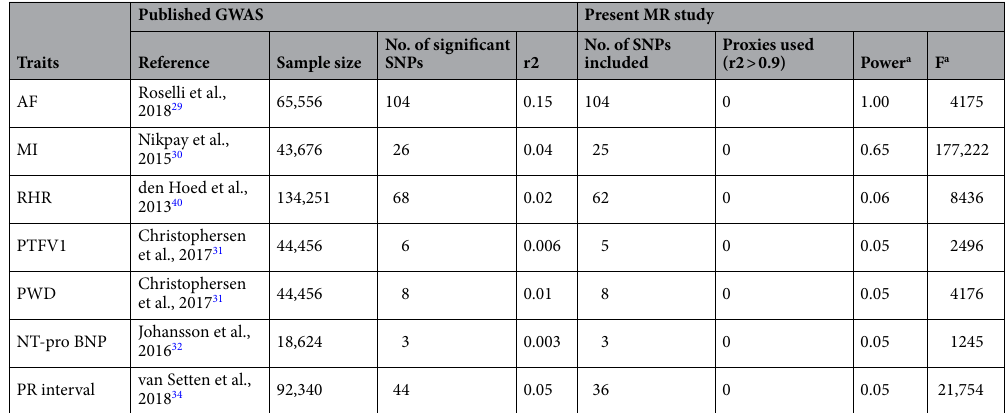
Table 1. Genome-wide association studies and number of single-nucleotide polymorphisms used as instrumental variables in the Mendelian randomization analyses of cardioembolic risk factors in relationship to stroke and its subtypes. AF atrial fibrillation, MI myocardial infarction, RHR resting heart rate, PTFV1 P ‐ wave terminal force in lead V1, PWD P ‐ wave duration. a Calculated for cardioembolic